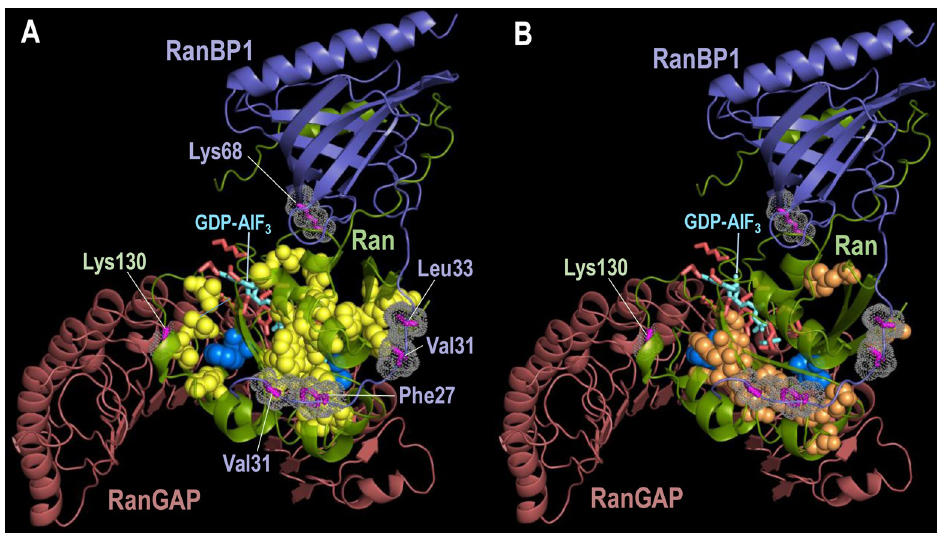
Fig 5. Residues in Ran involved in interacting pairs within the transition state structure (pdb: 1k5g) [37]. Sidechains of residues in RanBP1 contacting Ran are labeled in (A) and shown in magenta with dot clouds. The sidechain of Ran Lys130, which plays a role in the stimulation of GTP hydrolysis by RanGAP [37], is indicated. The GTP transition state analog and sidechains of Ran’s catalytic (active site) residues are represented as cyan and red sticks, respectively. A PyMOL session file corresponding to this figure is available at our website. A . Sidechains of residue pairs contributing to the higher S for Ran in the transition state than in the ground state (pdb: 1k5d). These residues are represented as yellow spheres, except for the pivot point residues Phe90 and Val14, which are shown as bright blue spheres, and for two of the unlabeled catalytic residues shown in red (Thr24 and Thr42). B . Ran residues forming pairs whose interactions remain stable over diverse conformational forms (shown as orange and bright blue spheres). These diverse forms include the Ran-RanBP1-RanGAP transition (pdb: 1k5g) and ground (pdb: 1k5d) states; Ran bound to its exchange factor, RCC1 (pdb: 1i2m); Ran bound to GDP (pdb: 3gj0); Ran bound to Ntf1 and GDP (pdb: 1a2k); and Ran bound to RanBP1 and CRM1 (pdb: